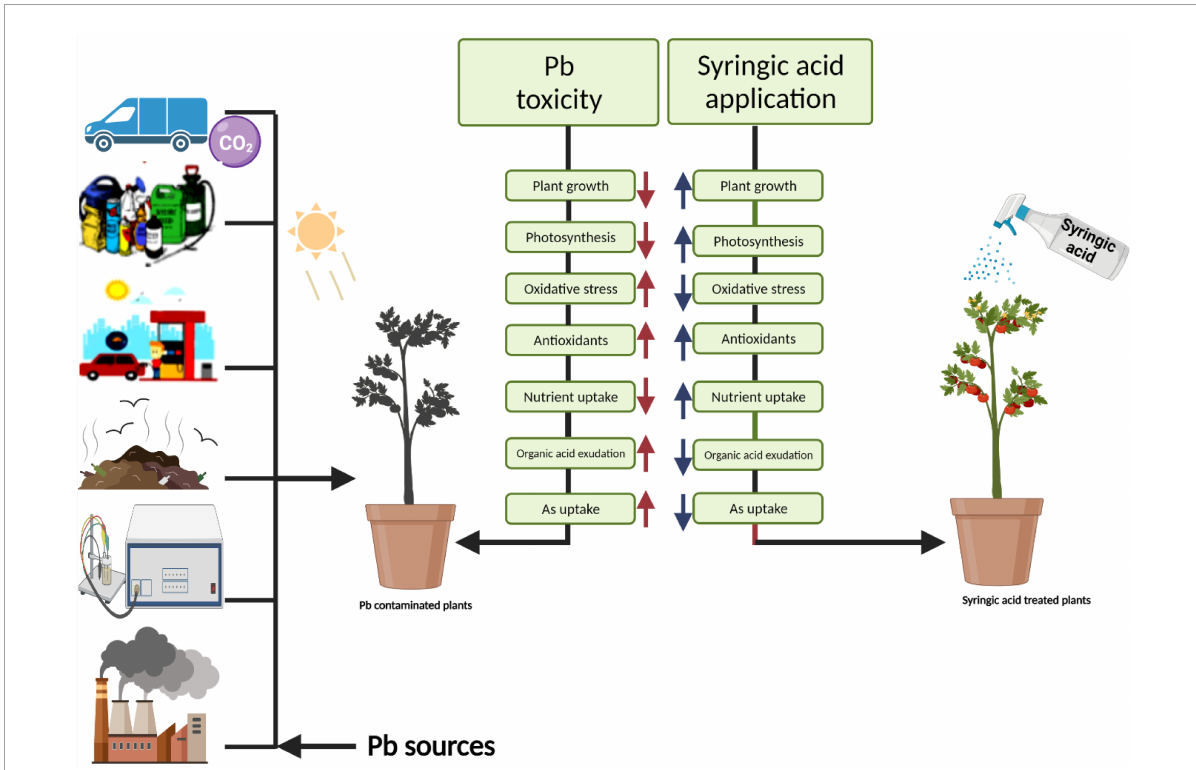
FIGURE10 Schematic presentation interpreting the mechanistic role of syringic acid in the alleviation of lead toxicity in Solanum lycopersicum . Pb toxicity inhibits plant growth characteristics and higher oxidative stress, organic acid exudation, and Pb concentration in the roots and shoots of S. lycopersicum . In contrast, the application of syringic acid alleviated Pb toxicity and improved plant growth and biomass, photosynthetic efficiency, antioxidant defense system, and nutritional status of the plant. In addition, the application of syringic acid decreases the contents of organic acid, oxidative damage in the plant tissues, and Pb contents in the roots and shoots of S. lycopersicum . The current study demonstrated that syringic acid could relieve Pb toxicity in S. lycopersicum by reducing Pb concentration in the various parts of plants and regulating the nutritional status of the